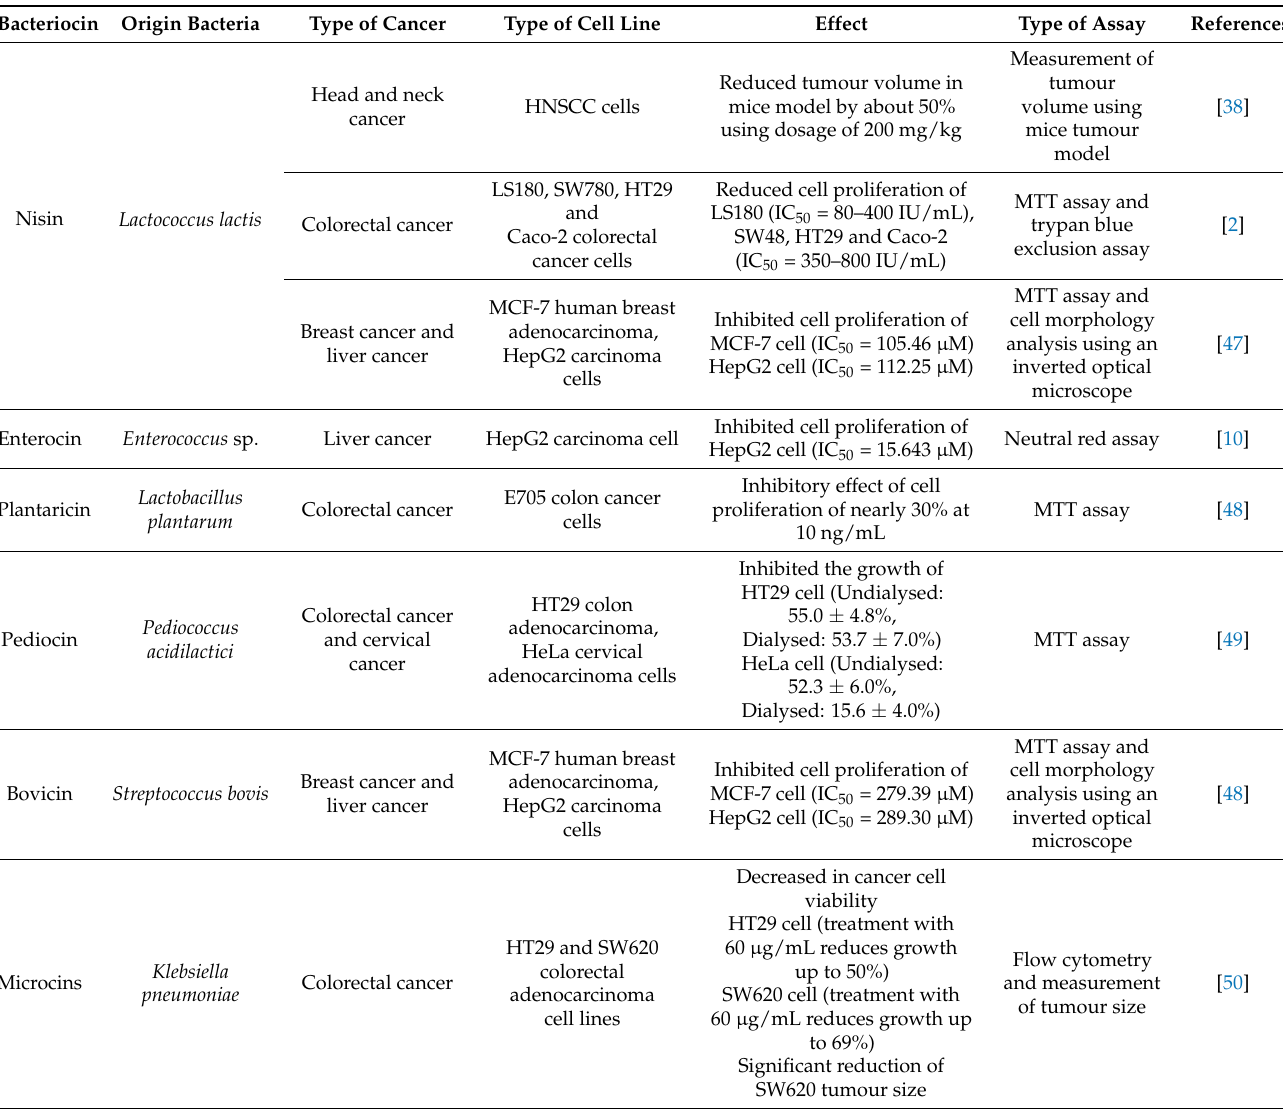
Table 1. Studies of bacteriocins towards different cancer cell lines using different